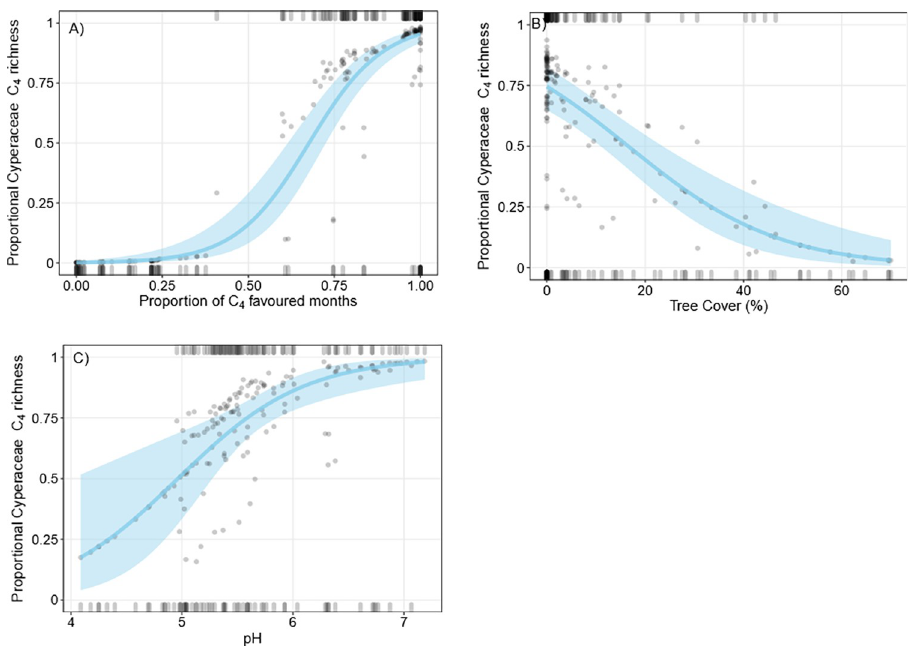
Fig 4. Binomial logistic regressions of proportional C 4 Cyperaceae richness. Grey points are partial residuals, blue lines and shaded bands are predicted outcomes of the regression and 95% confidence intervals respectively, and rugs were drawn to indicate observations with positive residuals (top of the plot) or negative residuals (bottom of the plot). For each plot (A-C), independent variables not depicted on the x-axis were held constant at their median value.